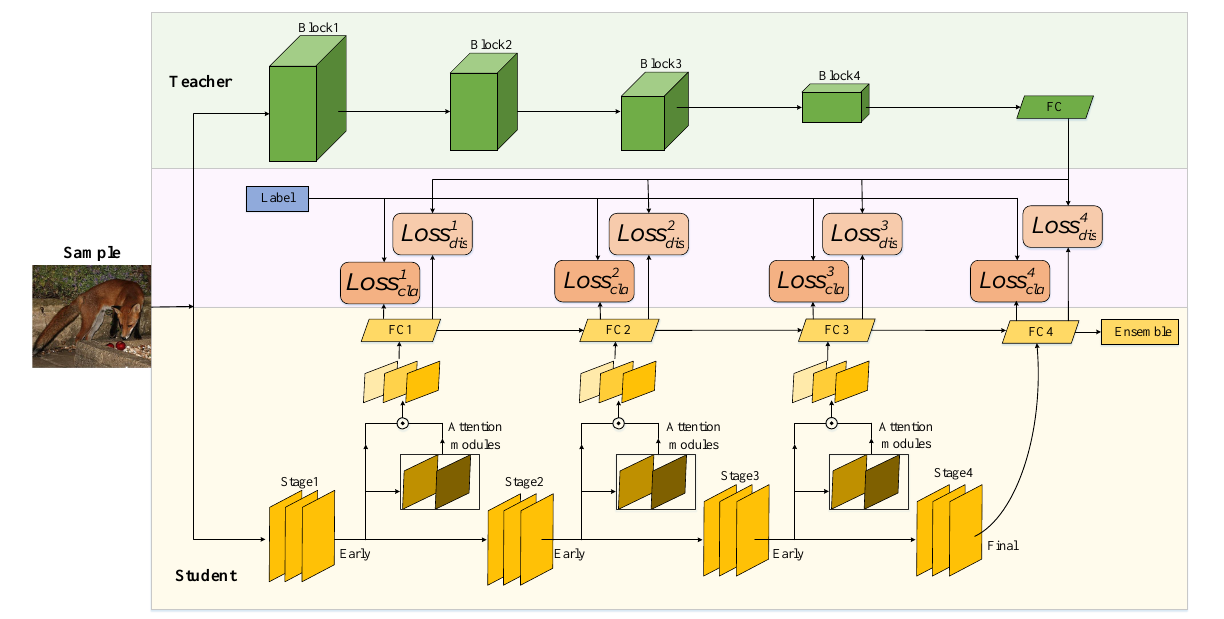
Figure 2. Overall framework diagram of the MSKD. Each of these exits possesses a distillation loss from the teacher network and classification loss from the true labels.